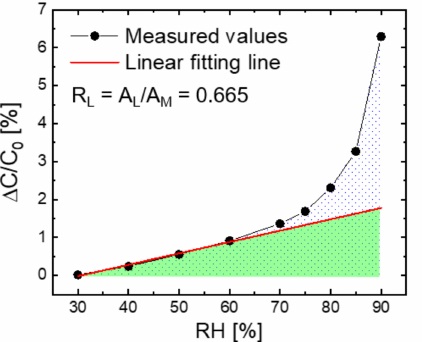
Figure 2. An example graph of humidity response plotted as relative capacitance change ( ∆ C/C 0 ) with RH. The ratio of response linearity (R L ) is defined as the ratio of the integral area of the linear fitting line (A L , the green-colored area) to that of the measured values (A M , the dotted